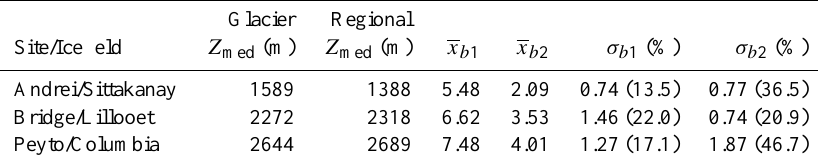
Glacier Regional